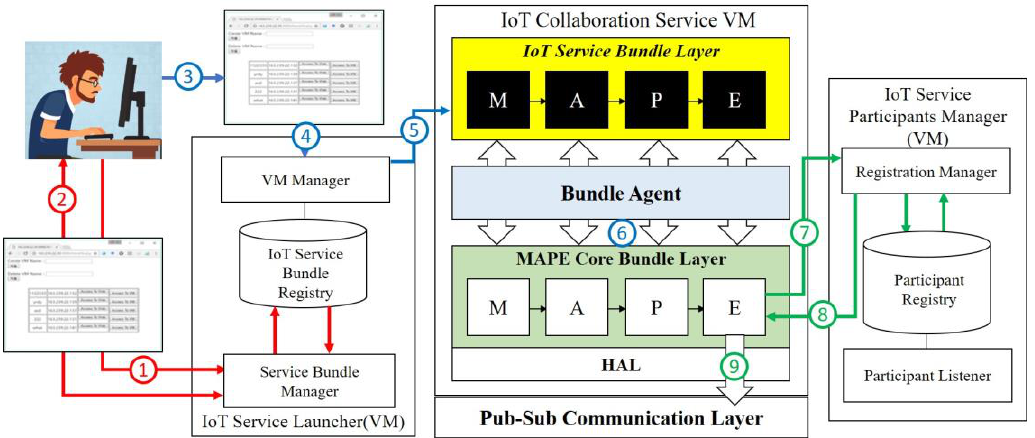
Figure 2. Provided facilities and mechanisms for launching and running an IoT collaboration service.